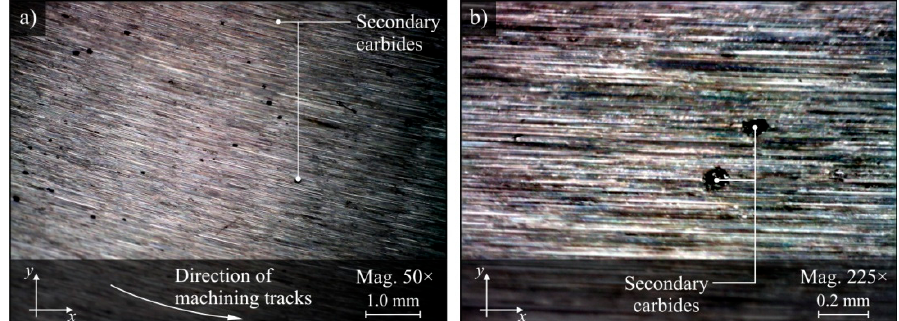
Figure 8. Microscope images of the workpiece surface machined by delivery of cooled compressed air, with visible surface inclusions recorded by the Dino-Lite Edge AM6715MZT digital measuring microscope: ( a ) magnification 50×; ( b ) magnification 225×.